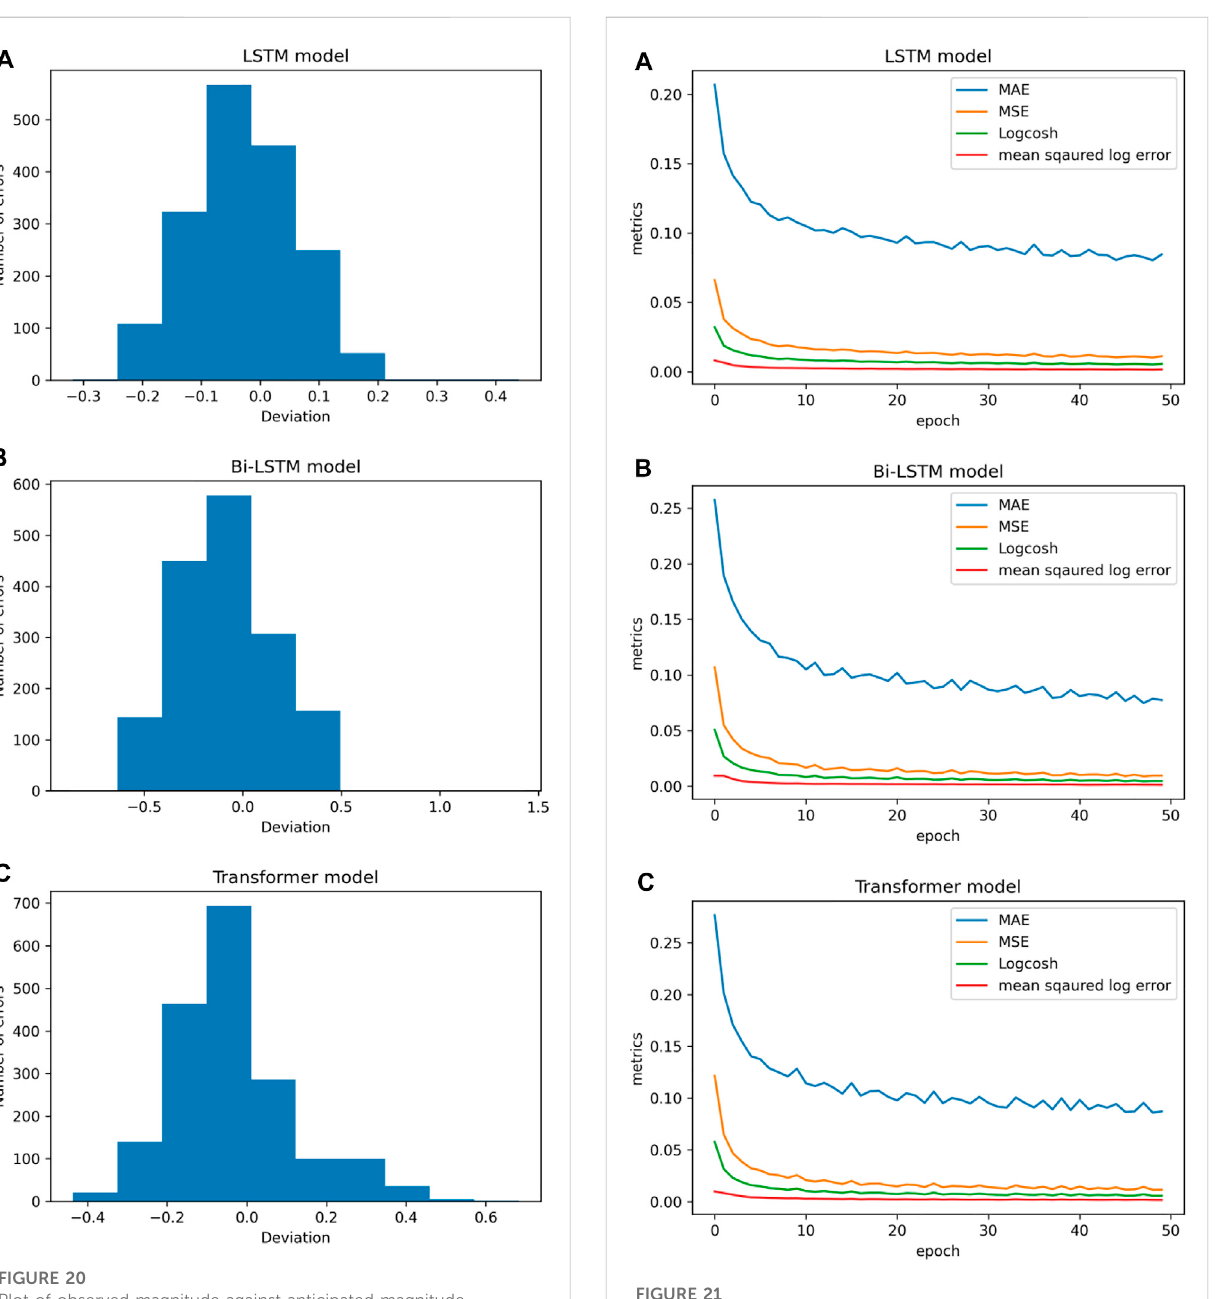
FIGURE 21 Performance metrics using (A) LSTM, (B) Bi-LSTM, and (C) transformer model on the HKKH region earthquake